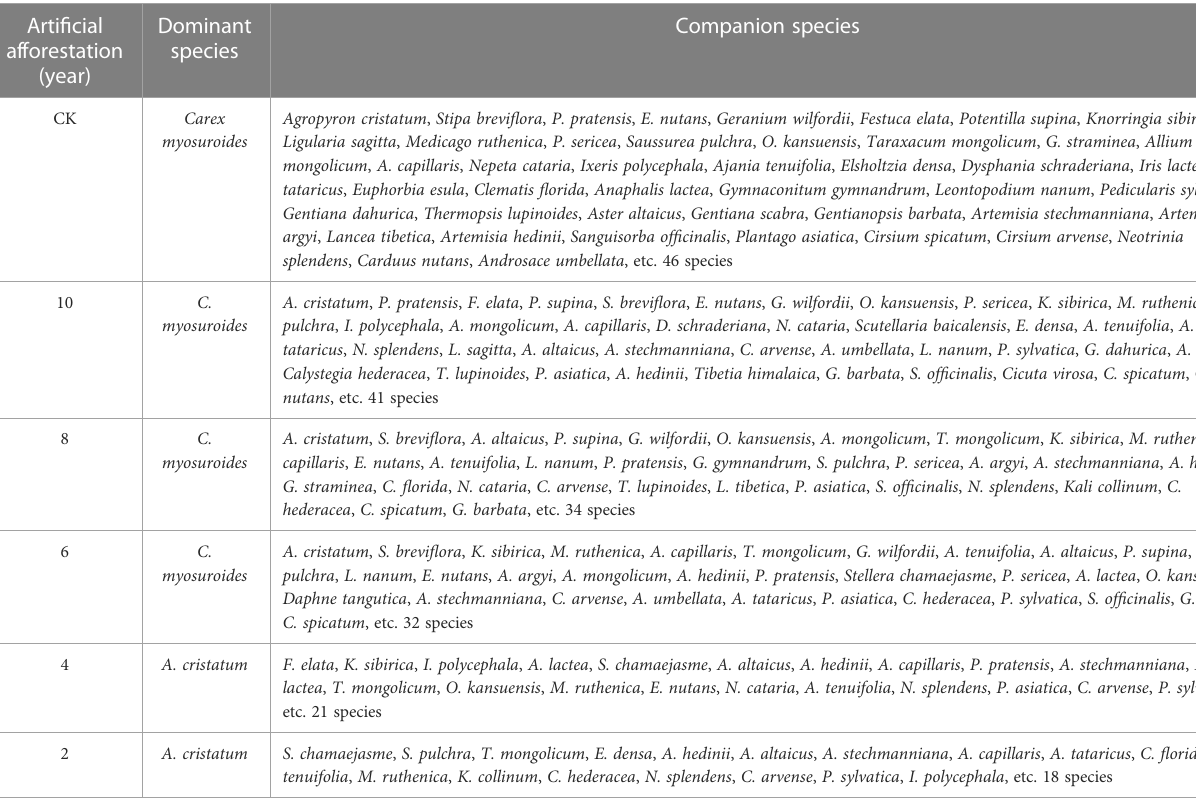
TABLE 2 Grassland plant community components of different arti fi cial afforestation years in the Maxian Mountain area of the Loess Plateau. Arti fi